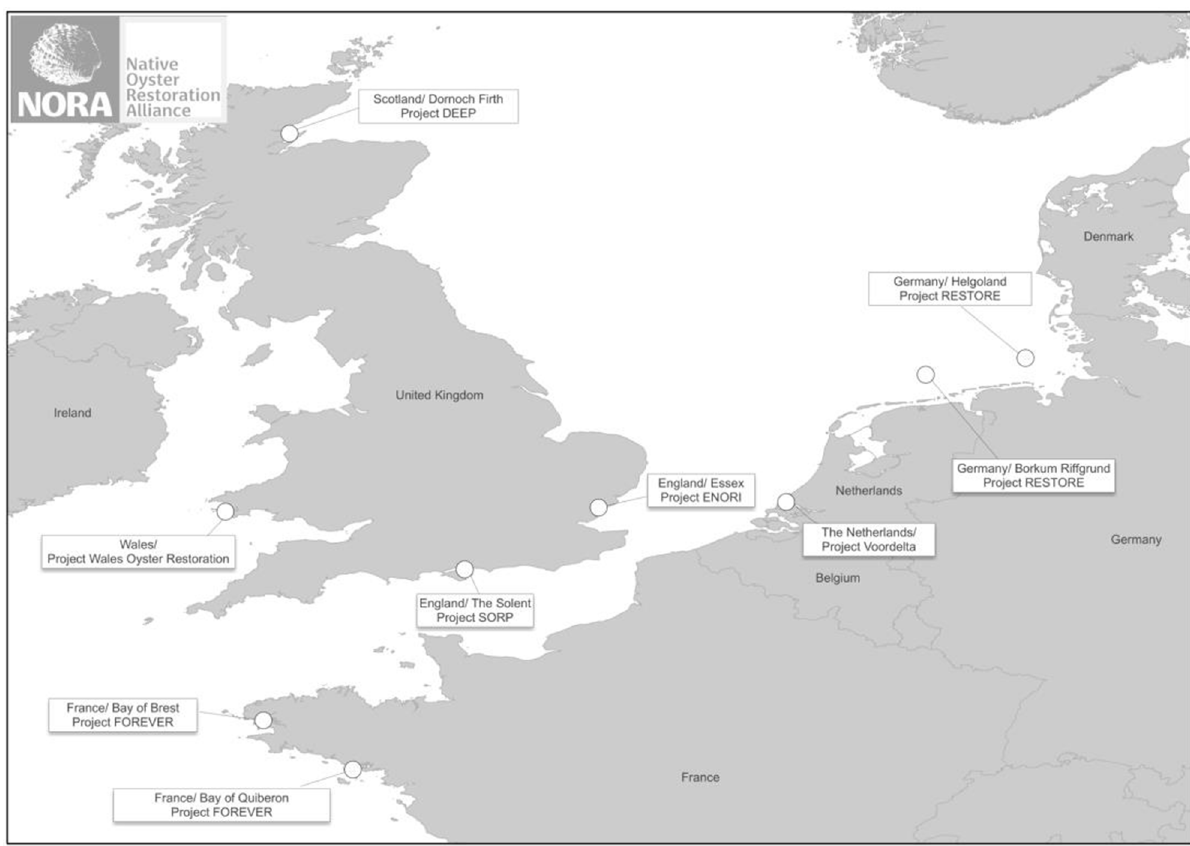
Fig. 1. Map of the North Sea and adjacent European seas (GCS_WGS_1984). It shows European countries contributing to the Native